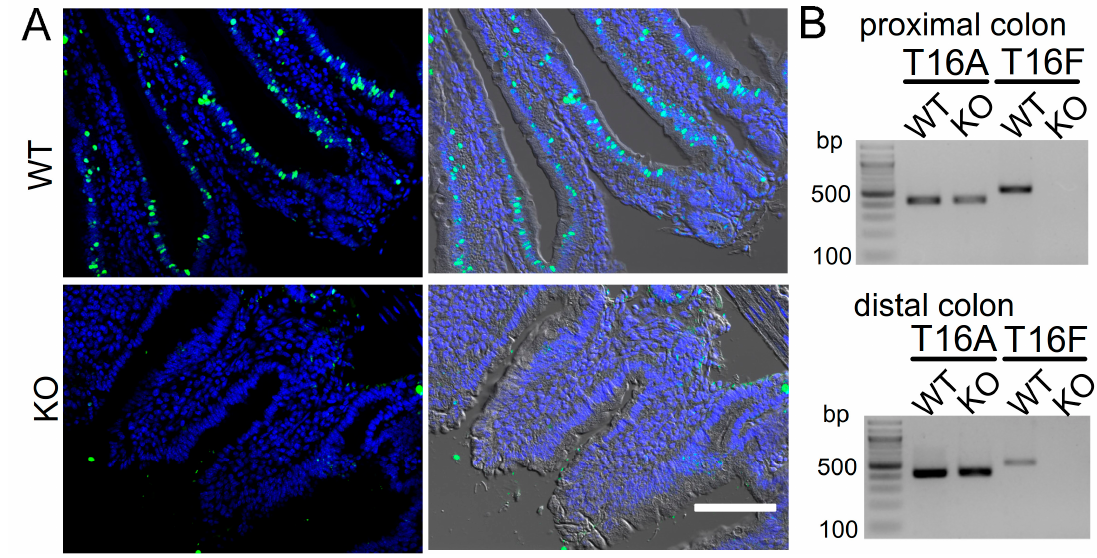
Figure 1. Cont . Figure 1.